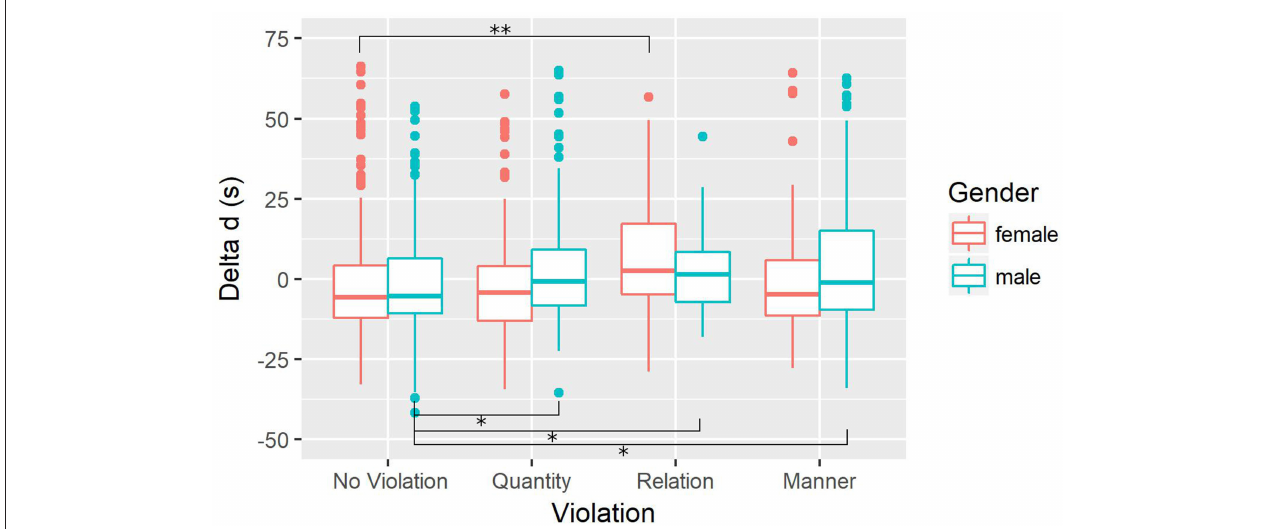
FIGURE 1 | Effect of violations and gender on 1 d (in seconds). “No Violation” refers to participant utterances in the conversation with the AI actor following messages in which there had been no violation (Control). ** p Holm < 0 .01, * p Holm < 0